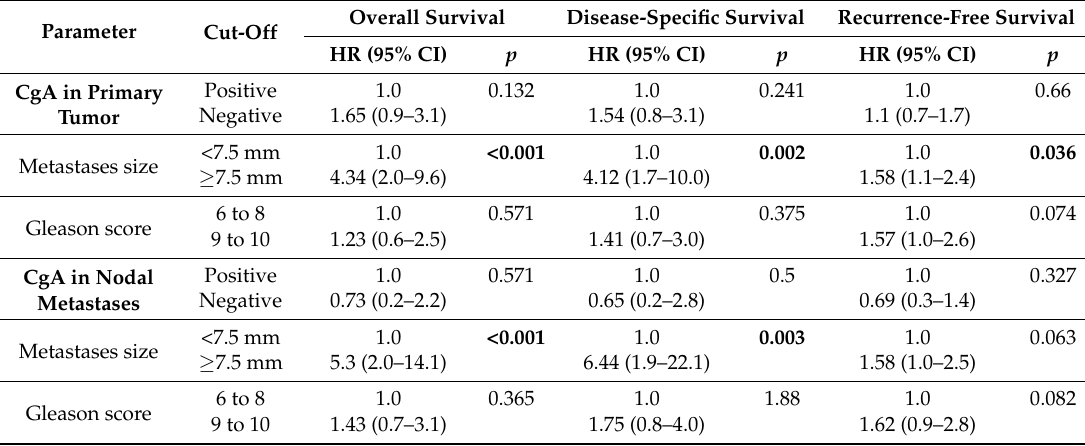
Table 3. Multivariate analyses for the prognostic impact of Chromogranin A (CgA) expression in primary prostate cancer (upper half) and in lymph node metastases (lower half), after adjustment for total size of metastases and Gleason score of primary tumor: Only nodal tumor burden predicts survival independently. HR, hazard ratio; and CI, confidence